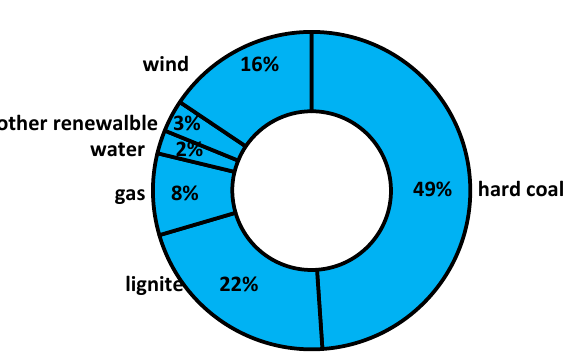
Figure 2. Structure of the electricity generation in the licensed large power plants in Poland at the beginning of 2023 (during two months: I–II).